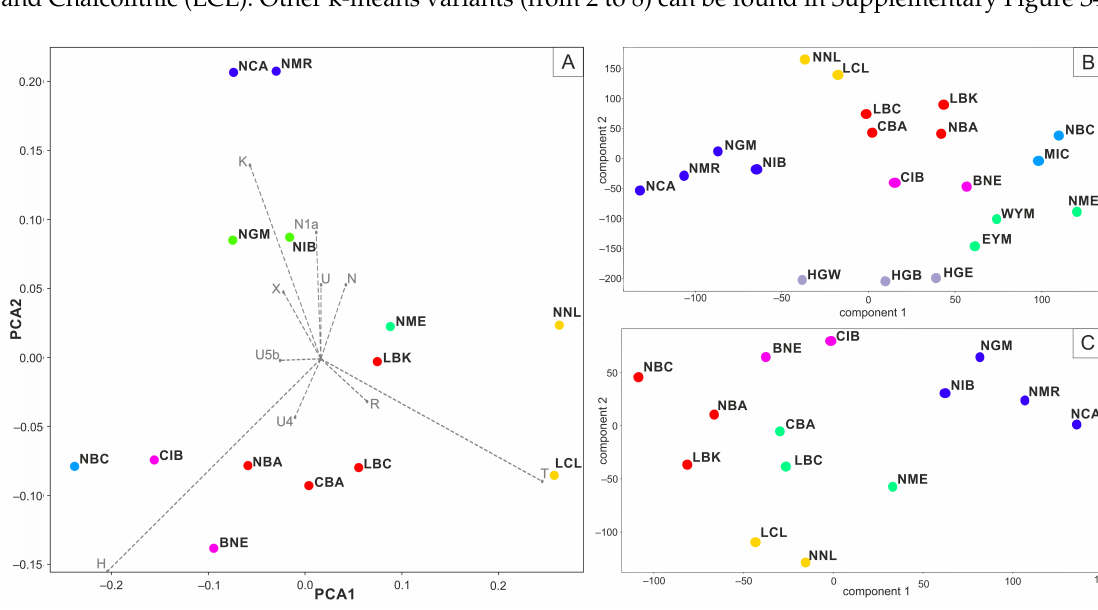
Figure 2. ( A ) Principal component analysis (PCA) plot with populations clustered according to k-means clustering (k = 7). ( B , C ) Plots of frequency based t-Distributed Stochastic Neighbor Embedding (t-SNE) with extended and reduced sets of populations clustered according to k-means clustering (k = 7 and k = 5, respectively). (BNE) Bronze Age Near East, (CBA) Chalcolithic Balkans, (LBC) Late Bronze Age Caucasus, (LCL) Late Chalcolithic Levant, (MIC) Minoan Create, (NBA) Neolithic Balkans, (NBC) Neolithic to Bronze Age Caucasus,(NCA)NeolithicCentralAnatolia,(NGM)NeolithicGreeceandMacedonia,(NME)NeolithicMiddle East, (NMR) Neolithic Marmara Region, (NNL) Natufian and Neolithic Levant, (CIB) Chalcolithic Iberia, (NIB) Neolithic Iberia, (LBK) Linear Pottery Culture, (WYM) Western Yamnaya, (EYM) Eastern Yamnaya, (HGW) Hunter Gatherers West, (HGE) Hunter Gatherers East, (HGB) Hunter Gatherers